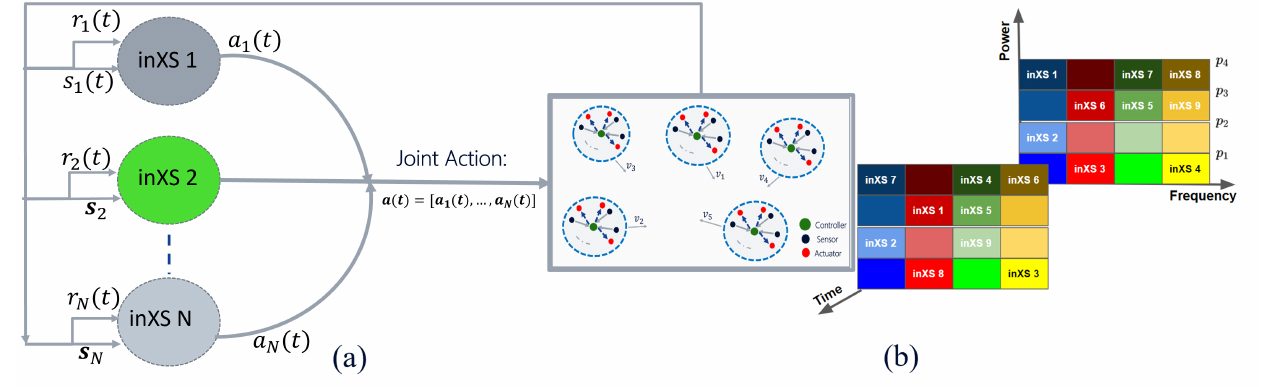
Figure 2. Illustration of the multi-agent RL scenario with N inXSs. ( a ) Multi-agent in-X Subnetwork Scenario; ( b ) Dynamic joint channel and power